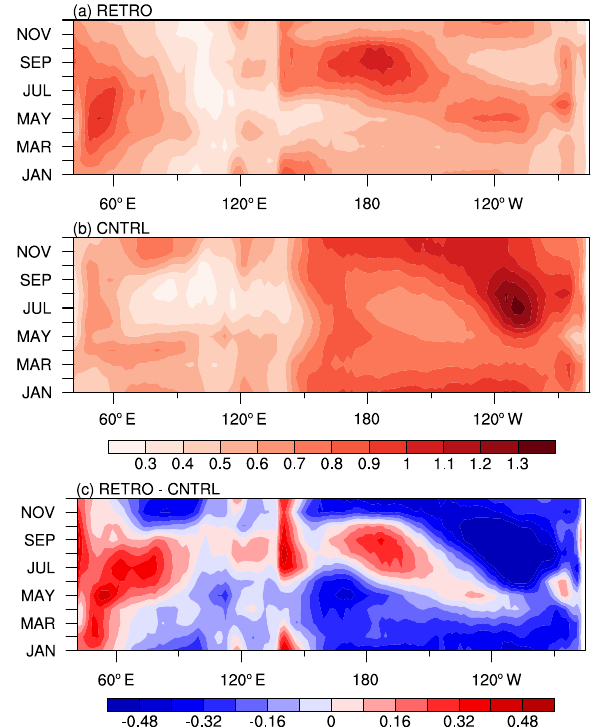
Figure A2. Sectional view of the seasonality of the sea surface temperature anomaly (SSTA) at the Equator (averaged between 5 ◦ S and 5 ◦ N) diagnosed as monthly deviation from the climatological annual cycle: (a) RETRO, (b) CNTRL, and (c) RETRO–CNTRL.